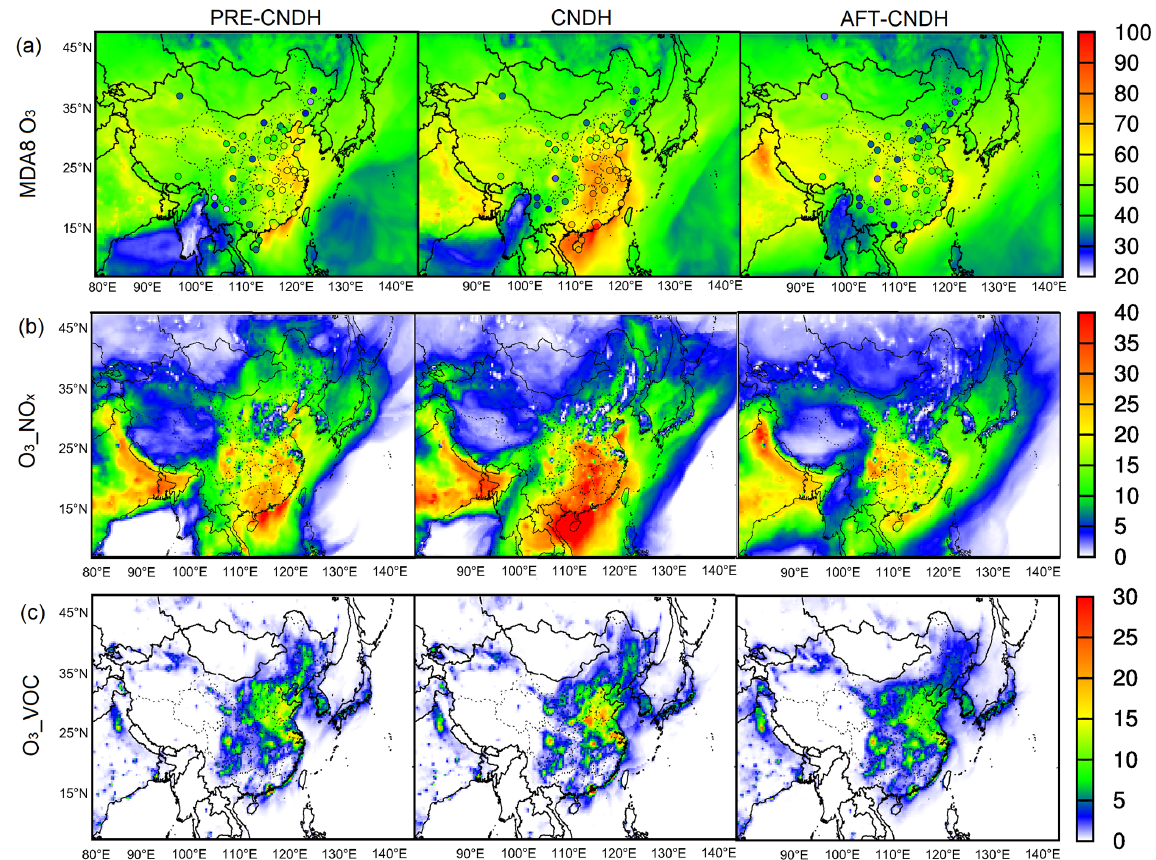
Figure 2. (a) Comparison of observed (circle) and predicted MDA8 O 3 . (b) Spatial distribution of O 3 _NO x . (c) Spatial distribution of O 3 _VOC in China in PRE-CNDH, CNDH, and AFT-CNDH, respectively. Units are parts per billion (ppb). O 3 _NO x and O 3 _VOC are the O 3 attributed to NO x and VOCs, respectively.